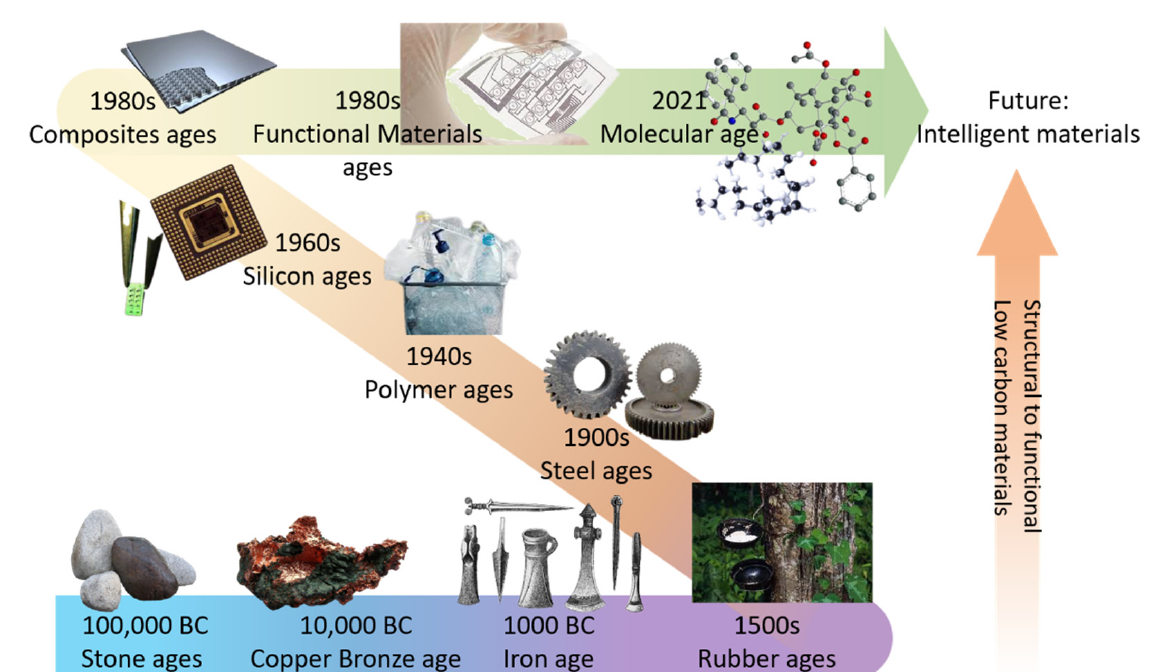
Figure 2. Historical and emerging tendencies of engineering materials.